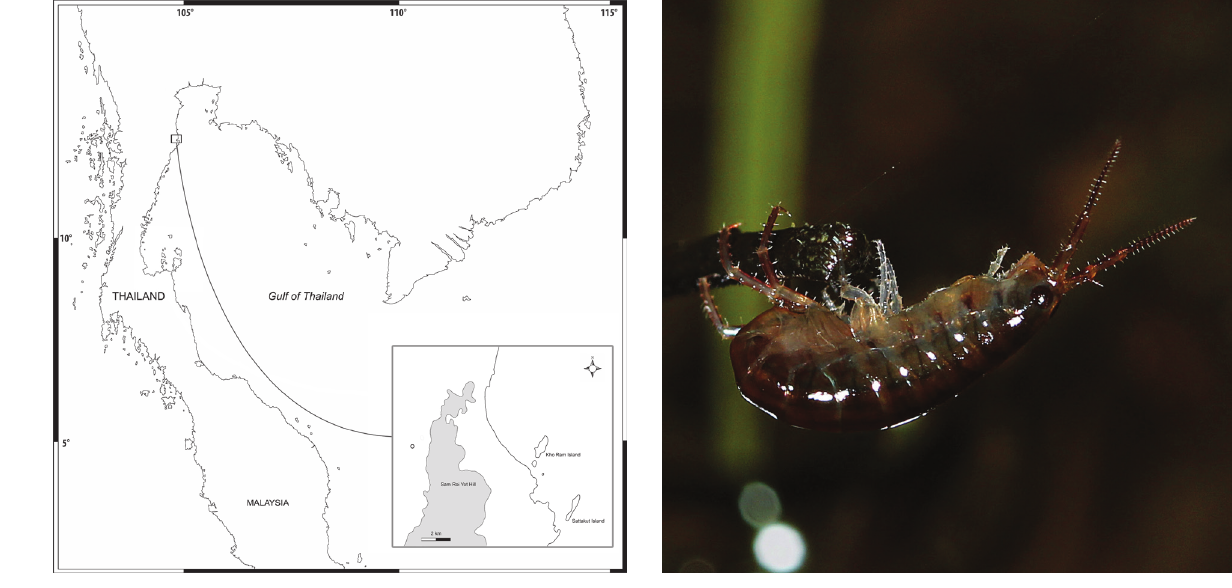
Figure 2. Live Floresorchestia samroiyodensis sp. n. in their nat- ural habitat; photo taken by Mr. Komson